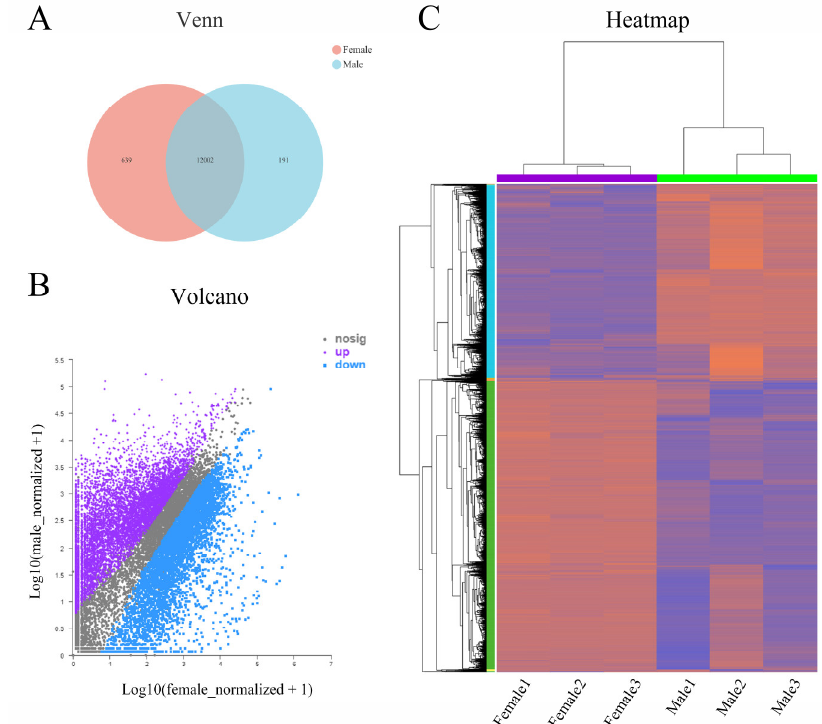
Figure 2. Differentially expressed genes (DEGs) between ovary and testis. ( A ): number of DEGs. ( B ): volcano maps of DEGs. ( C ): clustering of DEGs. ( B ): volcano maps of DEGs. ( C ): clustering of